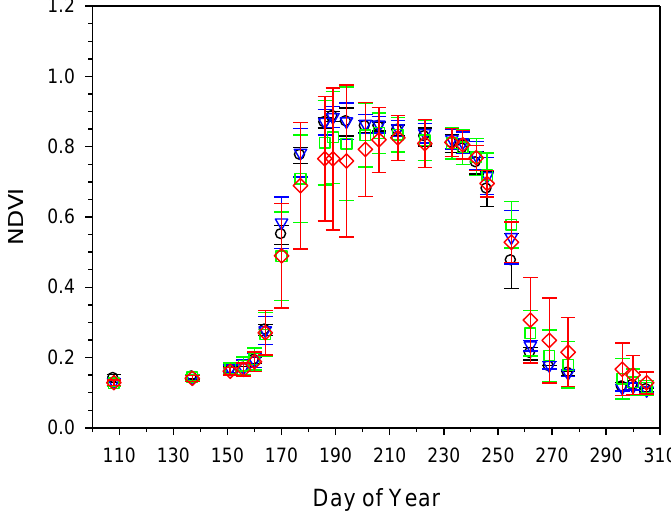
Figure 6. Values for NDVI and standard deviation for three tillage systems for corn grown in 2007.